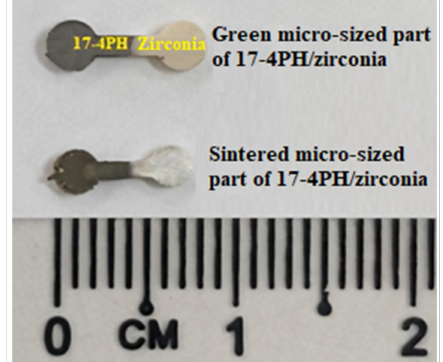
Figure 7. Photograph of green part and debound part sintered at 1350 ◦